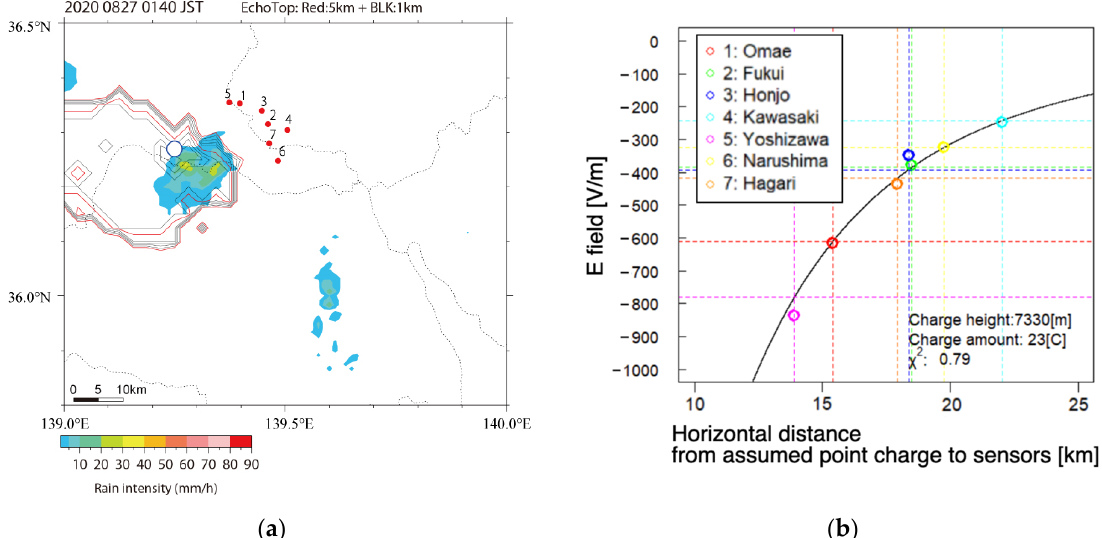
Figure 10. ( a ) Distribution of rain intensity at 2 km height, estimated by C-band radar at 1:40 (LT) on 27 August 2020. The blue circle indicates the estimated position of the assumed point charge in the cloud at 1:40:00 (LT). ( b ) The colored circles are the electrostatic field on the ground at each site. Horizontal axis shows the horizontal distance from the estimated position of charge to the sensors. The solid black line shows the result of fitting between the amplitudes of the electrostatic fields on the ground observed at seven stations and the calculated electrostatic field with the quantity and height of point charge determined by our method. (Adopted from [24]).